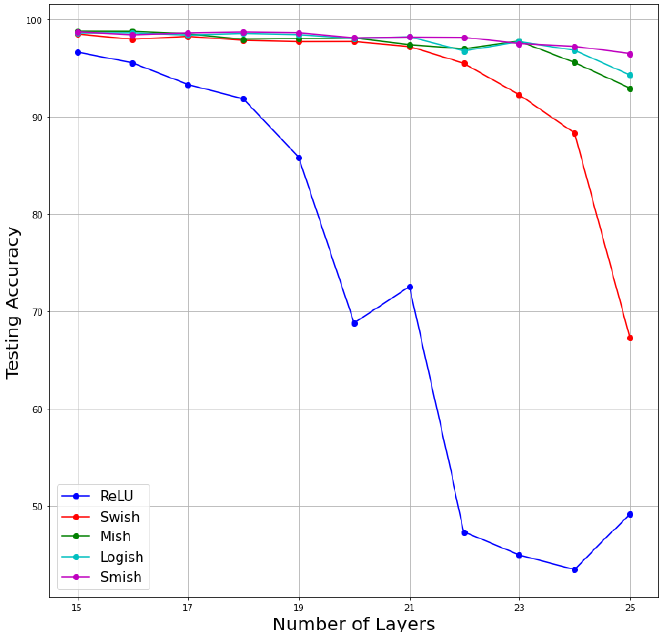
Figure 3. Testing accuracy vs. number of layers on MNIST for ReLU, Swish, Mish, Logish, and Smish.